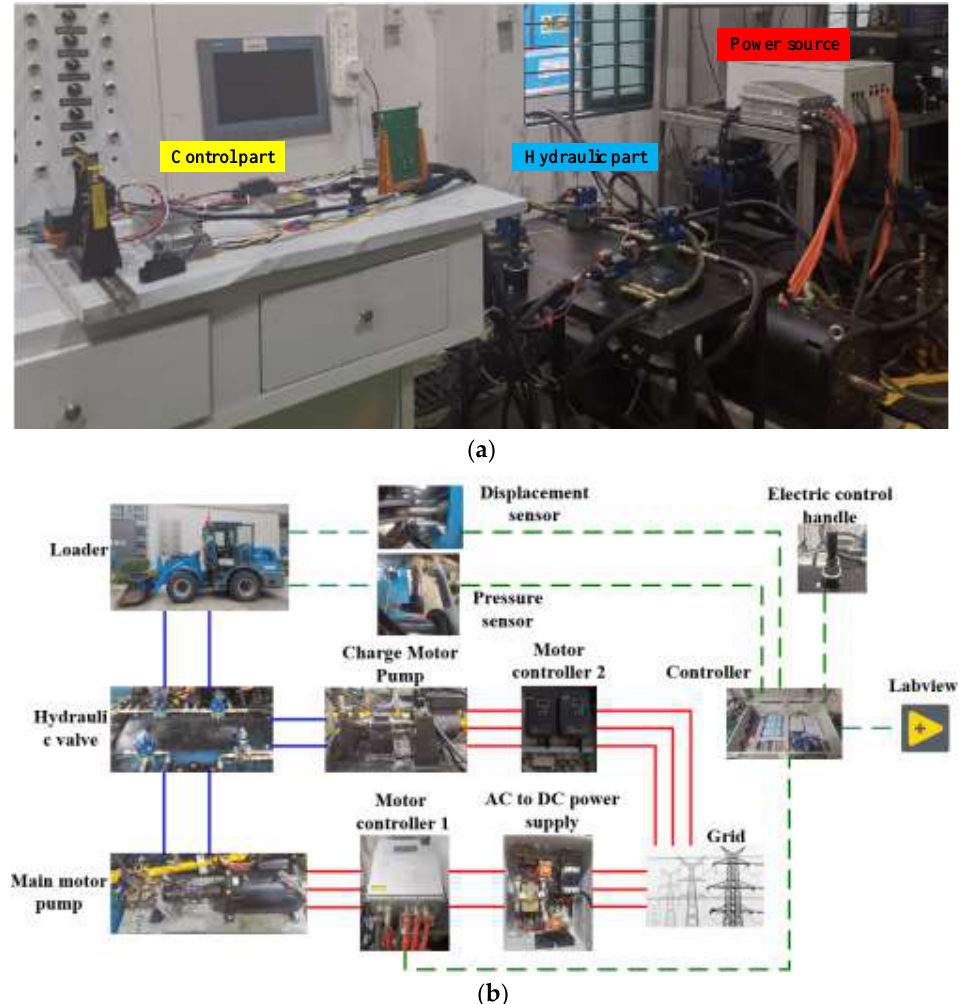
Figure 7. Steering system test platform. ( a ) Test platform; ( b ) Structural connection of test platform.